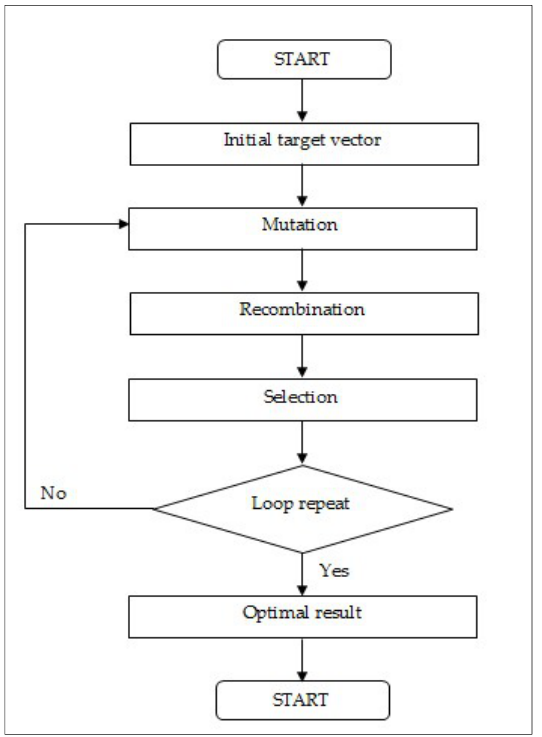
Figure 3. General Differential Evolution Algorithm Procedure.